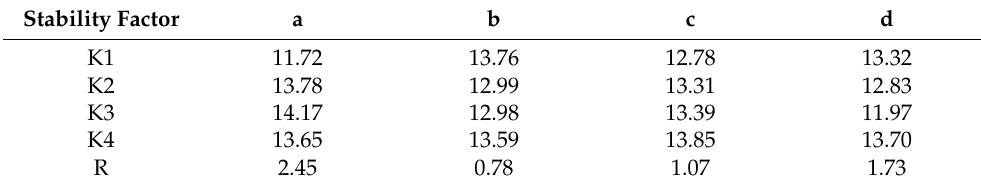
Table 15. Stability-range